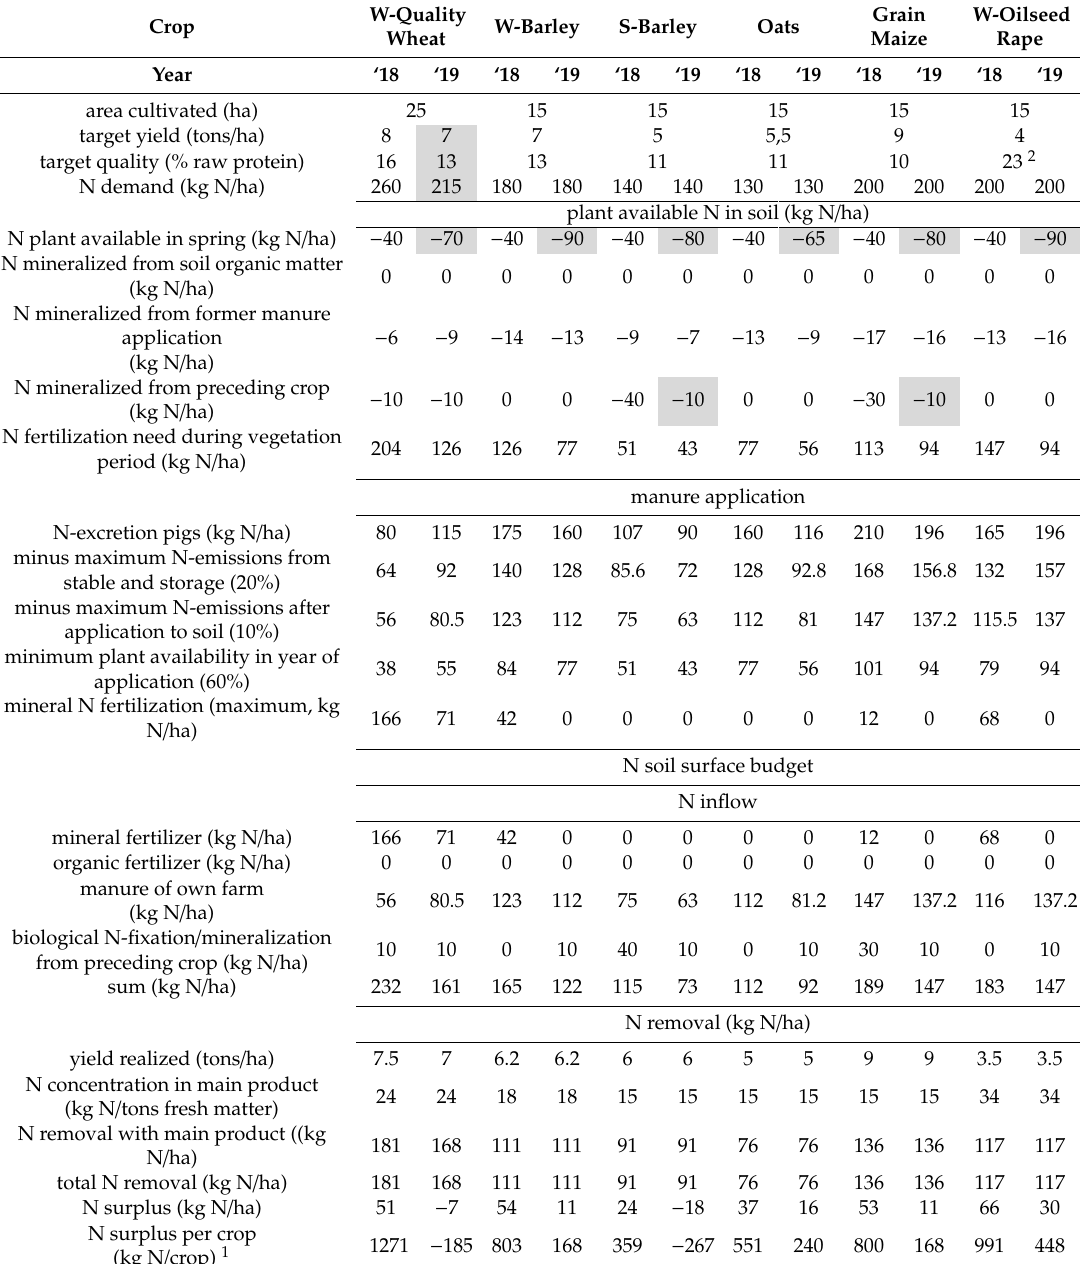
Table 4. Soil surface budget of a fictive 100 ha pig rearing model farm in the dry year 2018 and the year 2019, set up according to